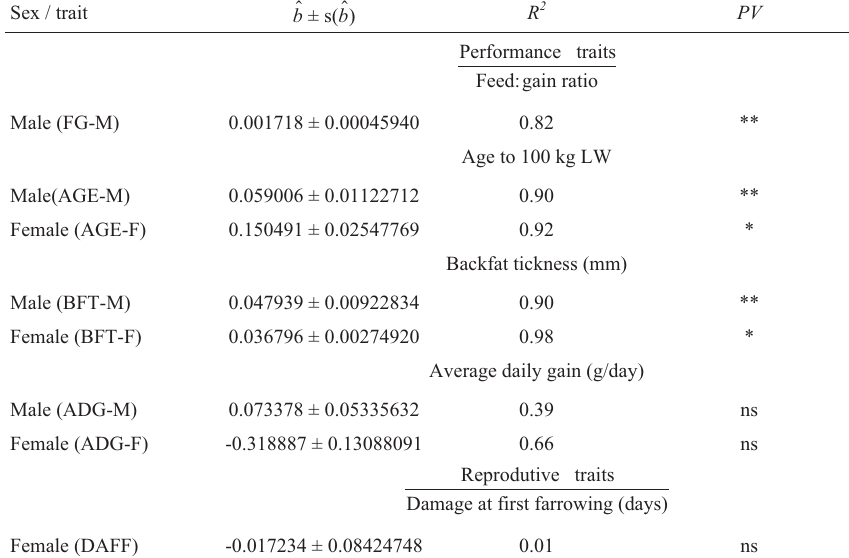
The estimated annual genetic trend of -0.23 ± 0.03 mm/year for BFT was lower than the value of -0.50 ± 0.03 mm described by Costa (1999), and lower than the -0.45, -0.43, -0,31 and -0.37 for Large White, Duroc, Hampshire and Landrace pigs reported by Chen et al. (2002). $ $ Table 2 - Genetic trend estimates ( b )), coefficients of determination (R 2 ) and probability values (PV) for the maternal b ) and respective standard errors (s( additive genetic